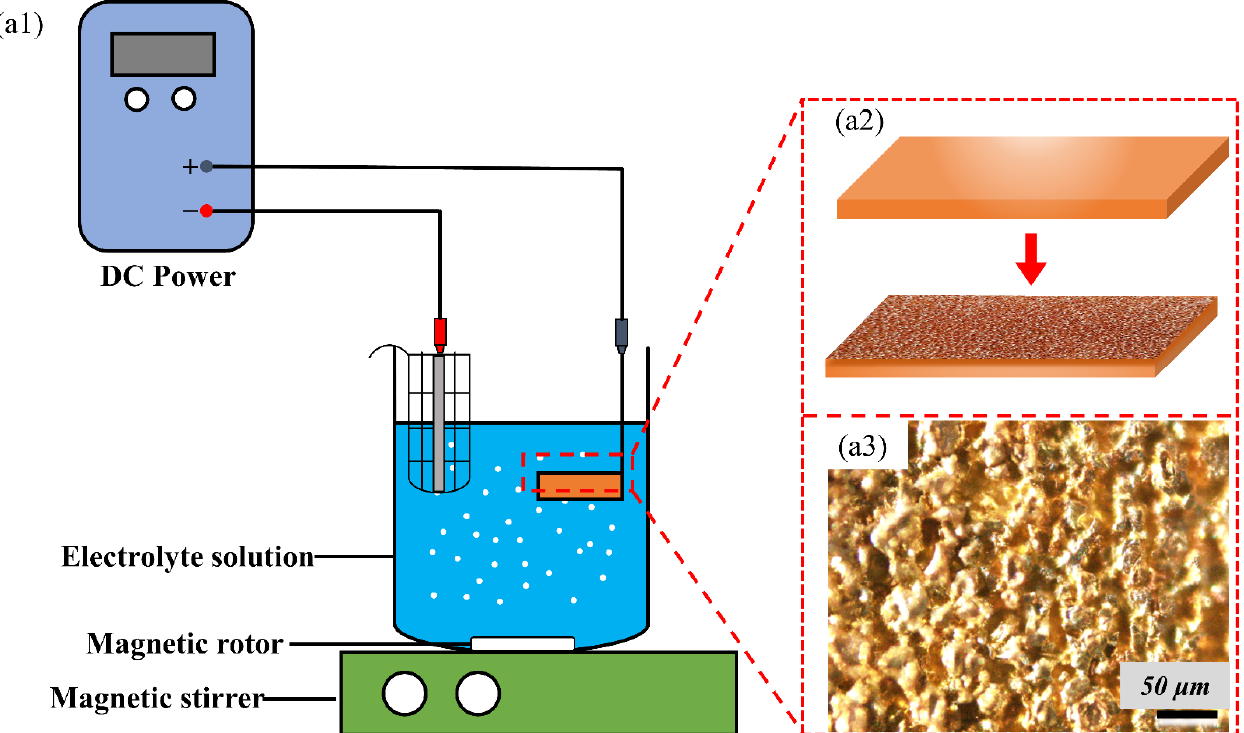
Figure 3. Constructing microstructures on the brass substrate by electrochemical etching: ( a1 ) the schematic diagram of electrochemical etching operation; ( a2 ) generation of disordered microstructures on the bare substrate by etching; ( a3 ) microscopic image of the brass substrate after electrochemi- cal